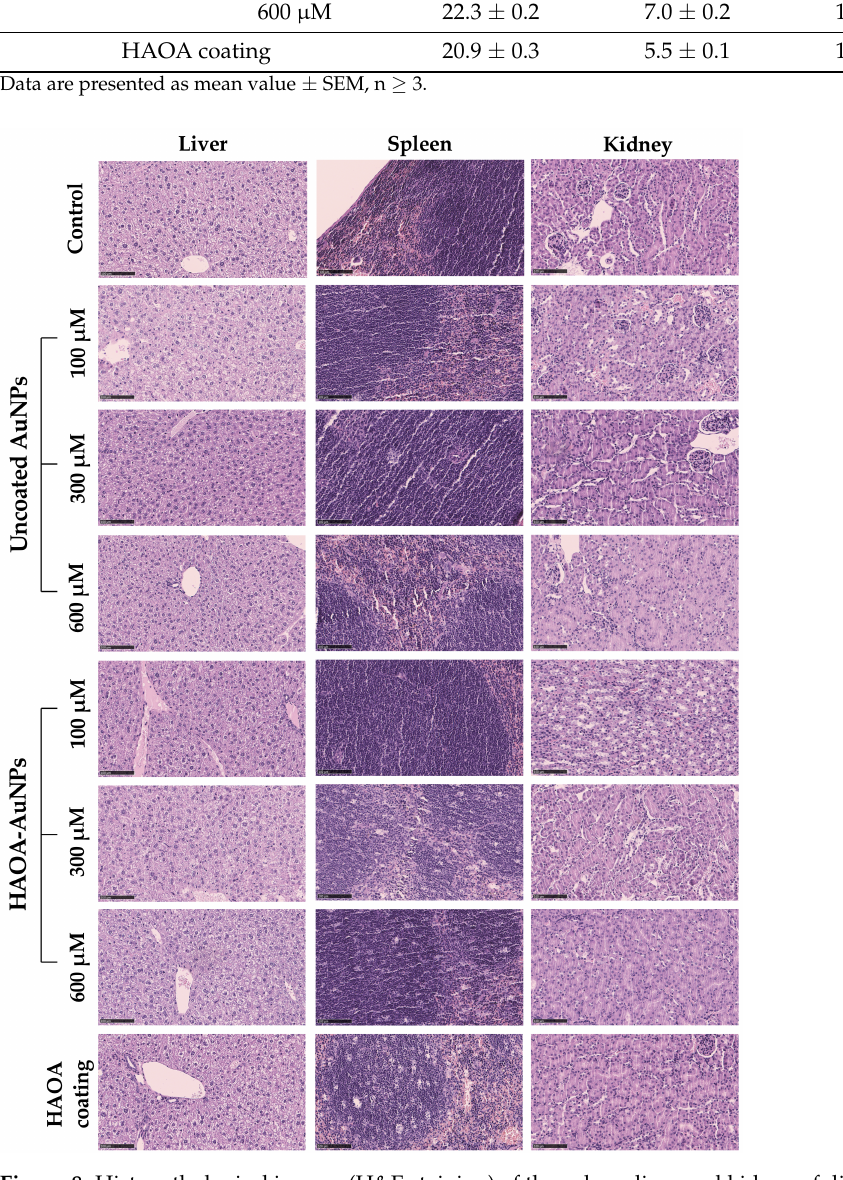
Figure 8. Histopathological images (H&E staining) of the spleen, liver and kidney of different groups of animals: control, uncoated AuNPs (100, 300 and 600 µ M), HAOA-AuNPs (100, 300 and 600 µ M), and HAOA coating. All images are representative of the harvested organs. Scale bars are 100 µ m for all the